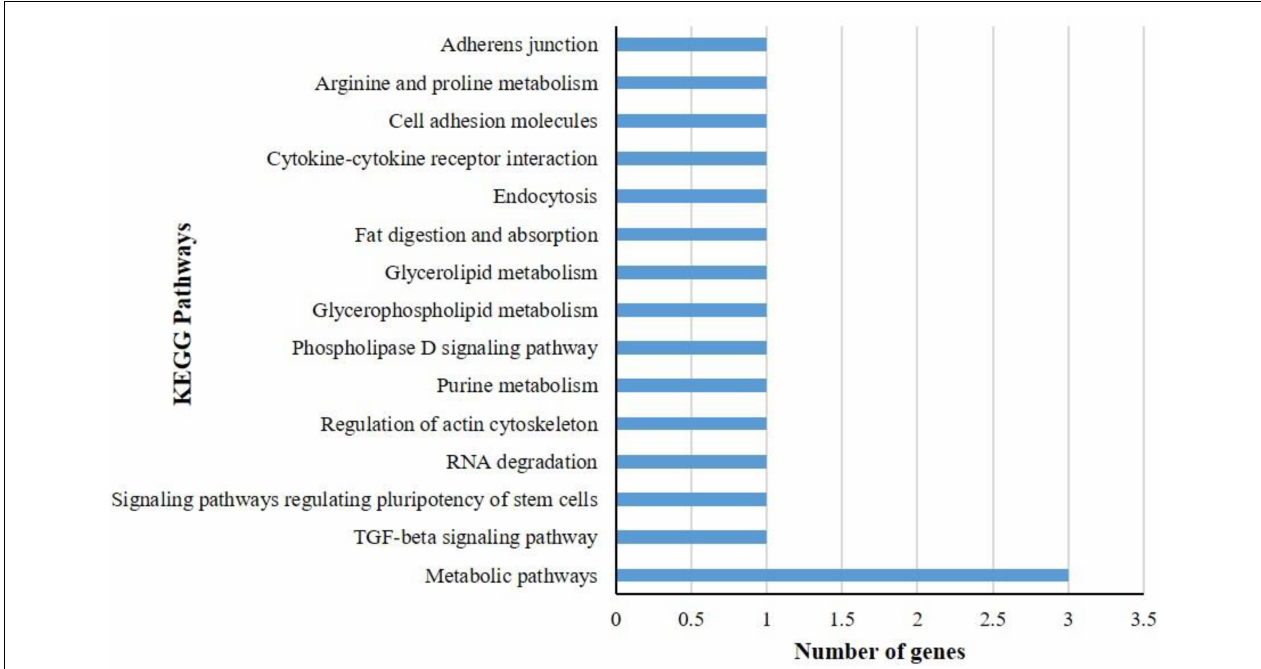
FIGURE 3 | KEGG pathway analysis of differentially expressed genes (DEGs) of B. tabaci Asia II 1 at an early stage of ChiLCV infection. KEGG pathway analysis of DEGs showed that the genes were involved in the functions like metabolic pathways, biosynthesis of secondary metabolites, signaling pathways, and actin cytoskeleton regulation in which mostly DEGs were involved in metabolic